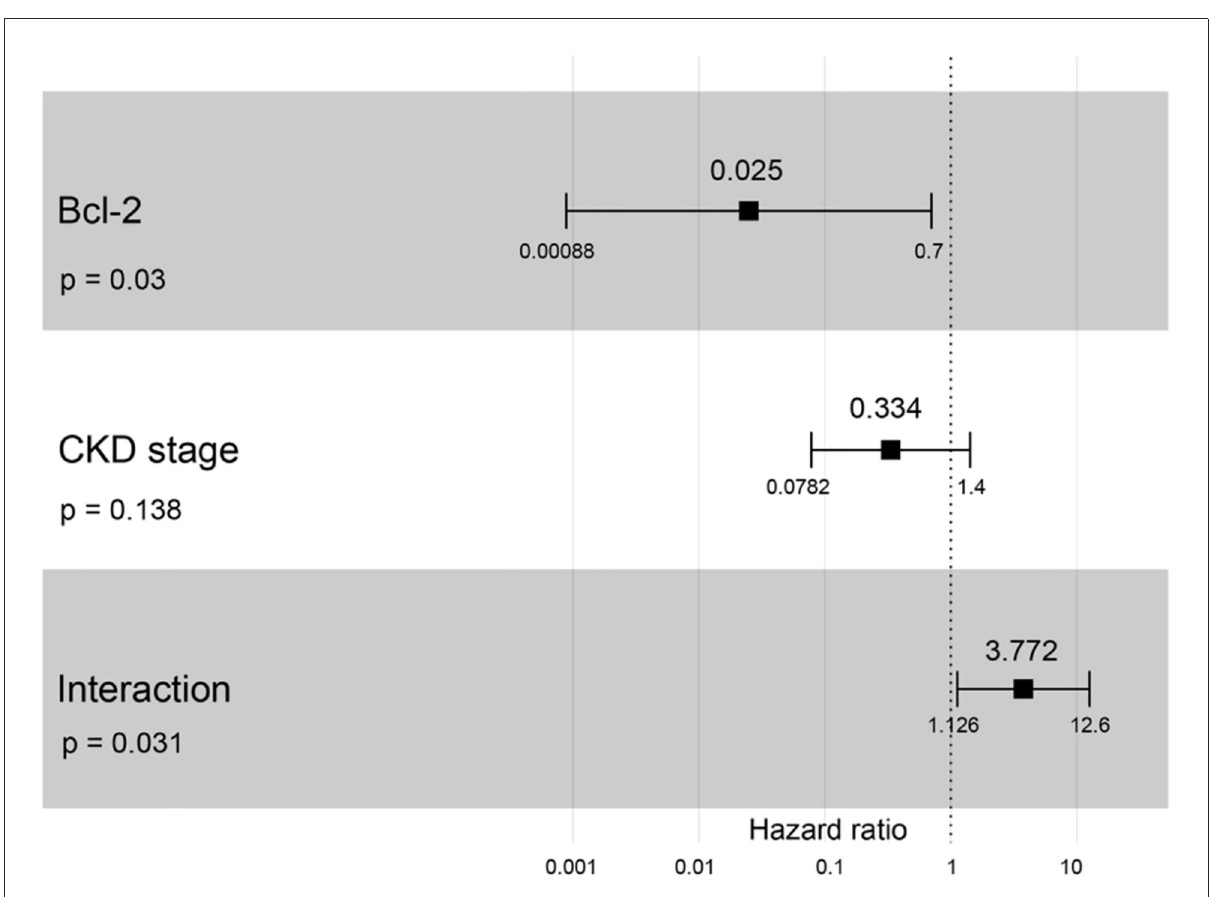
FIGURE8 Forest plot output for the interaction of Bcl-2 with CKD stage is covariate with CKD progression based on hazard ratios (HRs) as determined via Cox regression analysis. Squares represent hazard ratios. Bars represent 95% confidence